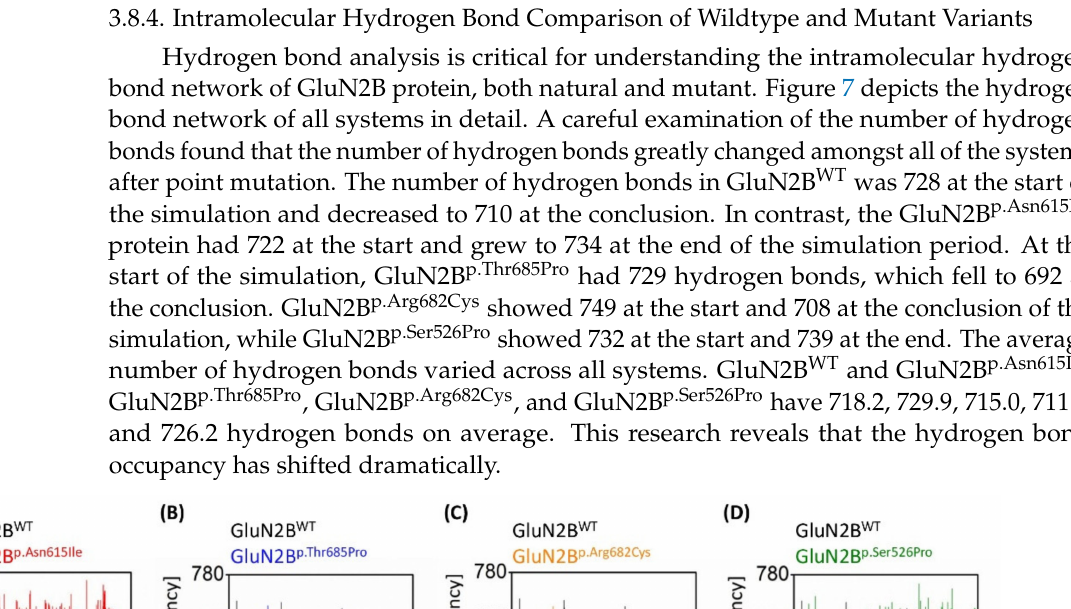
Figure 6. Black-colored lines in all graphs show the plot of the native GluN2B. Rg graphs of ( A ) GluN2B p.Asn615Ile , ( B ) GluN2B p.Thr685Pro , ( C ) GluN2B p.Arg682Cys , and ( D ) GluN2B p.Ser526Pro .